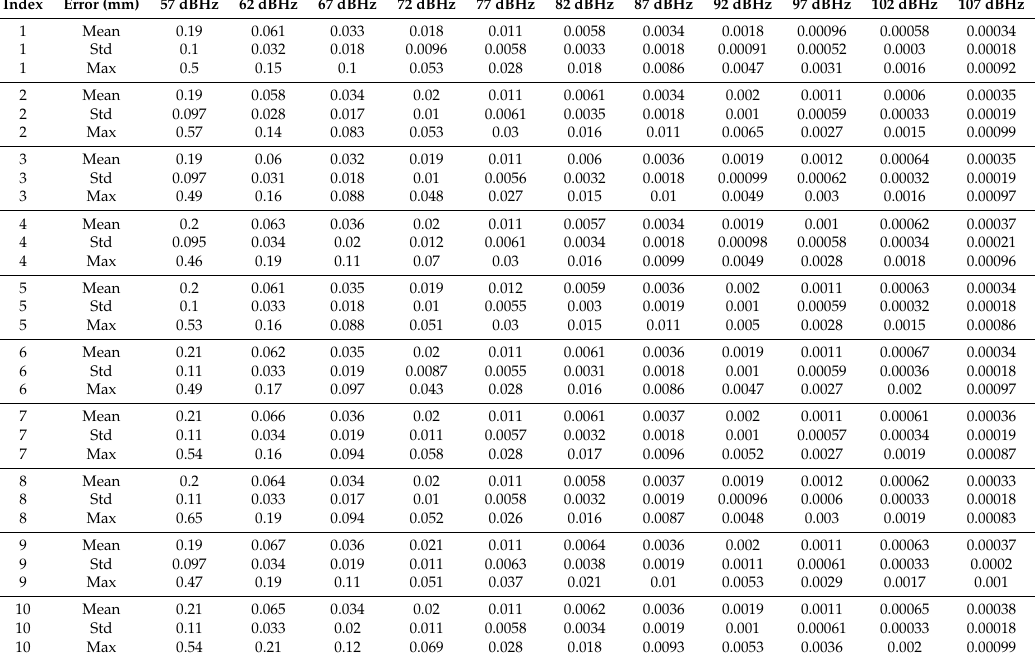
Table A4. Mean values, standard deviation, and maximum error values in the calculation of the impact point using FDMA-BPF with a 8-bit